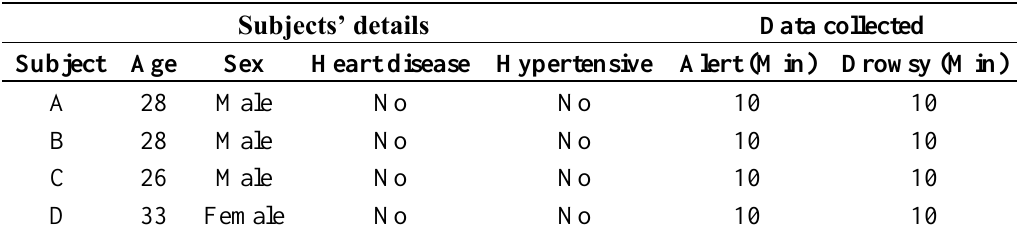
Table 5. Summary of the subjects‟ data.